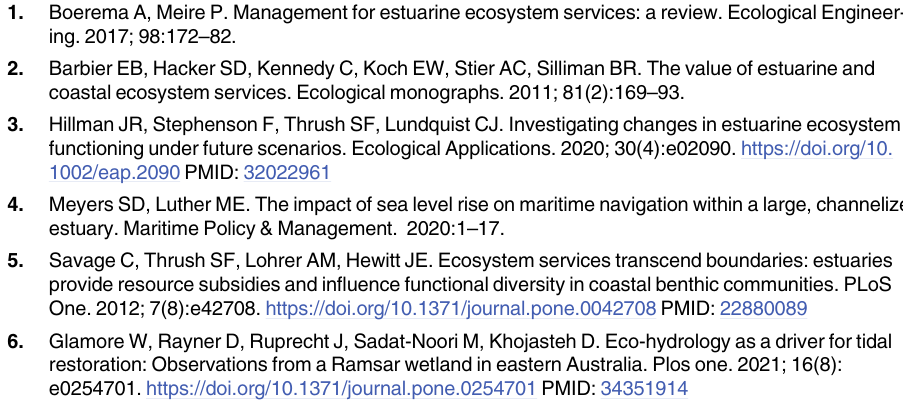
S11 Table. A summary of estuarine tidal range responses to SLR during medium river dis-